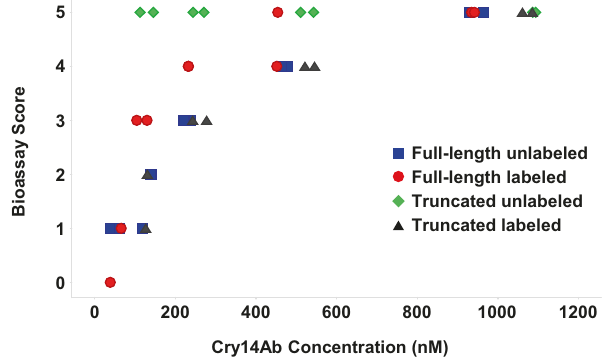
Fig. 5 Effect of full-length versus truncated, and fl uorescently labeled versus unlabeled, Cry14Ab on Caenorhabditis elegans in liquid bioassays. Full-length protein was wild type, while truncated protein had the mutation G708R, and was cleaved at that position with trypsin, followed by puri fi cation of the N-terminal fragment. Two technical replicates of each sample were assayed. The symbols have been jittered in the horizontal direction to make them more visible. The graphs were prepared using TIBCO Spot fi re, version 7.10.1. Blue squares: full-length unlabeled. Red circles: full-length labeled. Green diamonds: truncated unlabeled. Black triangles: truncated labeled. Source data are provided as a Source Data fi